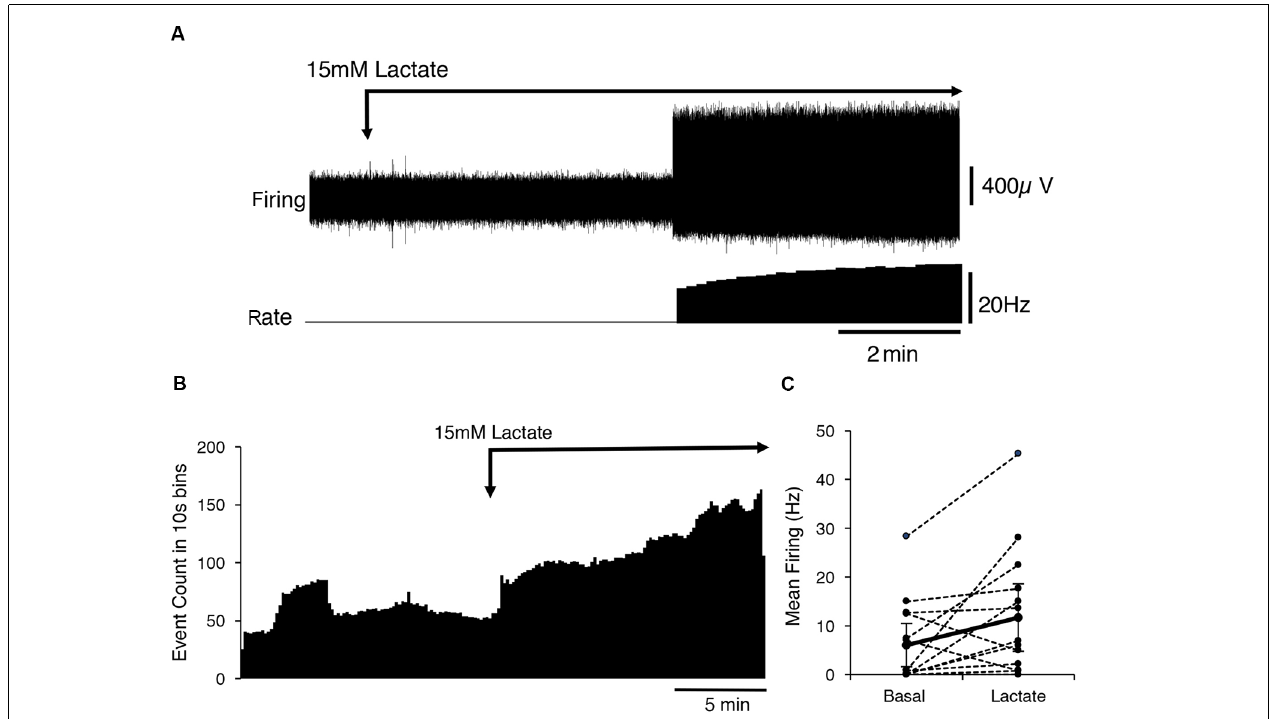
FIGURE 2 | Activation of CT3 afferents by superfusion with 15 mM Lactate (pH 7.4). (A) A typical example of the effects of the application of a 15 mM lactate solution; The Firing rate of a single identified CT3 unit is shown on the lower trace. The unit did not fire spontaneously but after several minutes of perfusion of lactate, there was an abrupt start of firing at about 15 Hz, which increased in frequency over the next few minutes. (B) The mean response of 14 discriminated CT3 units is shown during the application of 15 mM lactate solution, averaged over 15 min in 10 s bins (14 units, n = 13). Note the large sustained increase in spontaneous firing in the presence of lactate. (C) Comparison of basal firing (black dots) averaged over 15 min before and after the application of lactate for 14 identified CT3 units. Most units show an increase in firing in lactate, although two units showed a marked decrease in firing